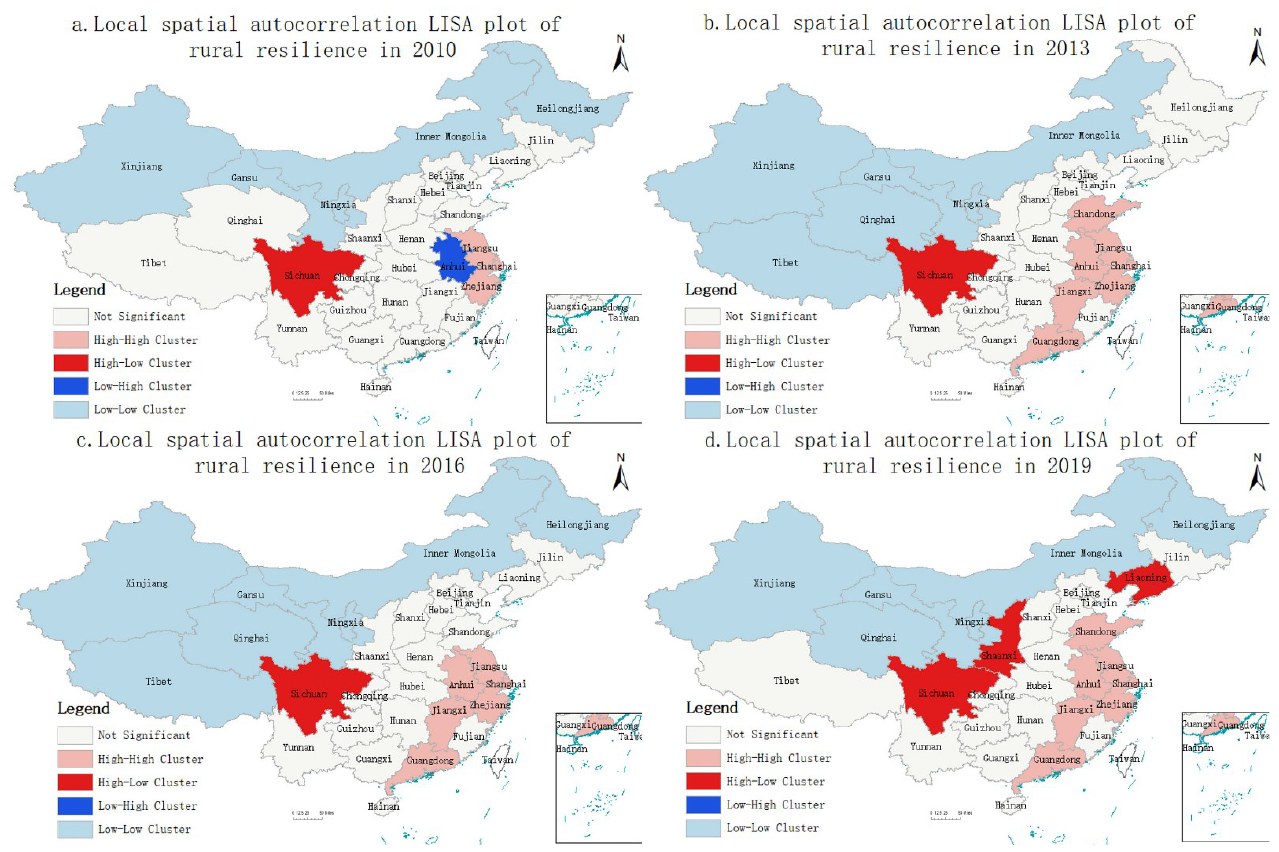
Figure 2. Local spatial autocorrelation LISA plots for rural resilience, 2010, 2013, 2016, 2019. H-H cluster is mainly distributed in the eastern region of China, with a stable expansion trend and obvious spatial spillover effects. In 2010, only three regions, Jiangsu, Shanghai and Zhejiang, were located in the H-H cluster region. Additionally, in 2019, Shandong, Jiangxi and Guangdong all transformed from not significant to H-H cluster, and Anhui transformed from L-H cluster to H-H cluster. It shows that Jiangsu, Shanghai and Zhejiang have significant polarization effects, and have a strong radiative driving effect on the surrounding areas, leading Anhui, Shandong, Jiangxi and Guangdong to transform to a high resilience level and finally form an H-H cluster region led by the Yangtze River Delta urban agglomeration and coordinated development of the eastern region.